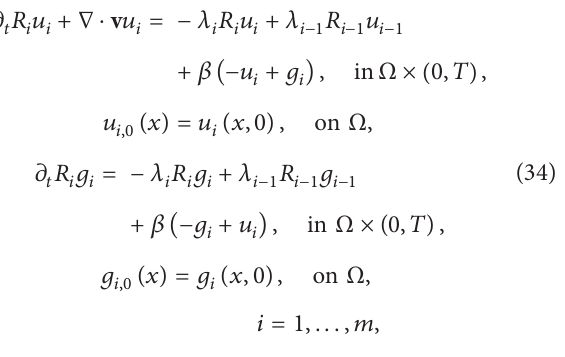
Figure 1: Numerical errors of the standard splitting scheme and the iterative schemes with the Zassenhaus formula, where we have at least 1,...,4 iterative steps.